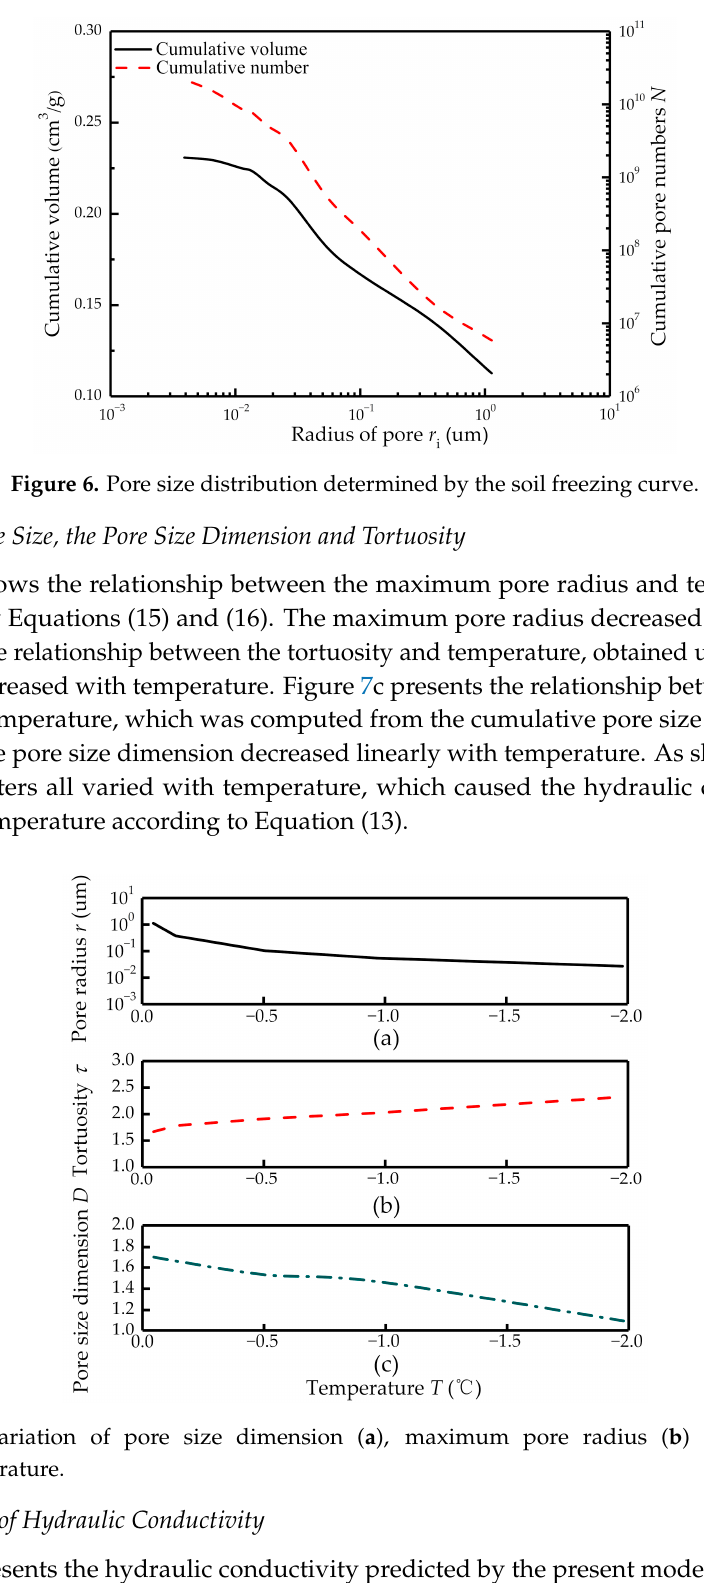
10 of 21 Figure 5. Soil freezing curve. 5. Results 5.1. Cumulative Pore Size Distribution Curve Here, the experimental data from Tokoro et al. [39] were used as an example to describe the calculation process for finding the hydraulic conductivity of frozen soil. Figure 6 presents the cumulative pore size distribution estimated by the SFC, with the solid line representing the cumulative volume of pores and the dashed line representing the cumulative number of pores. The